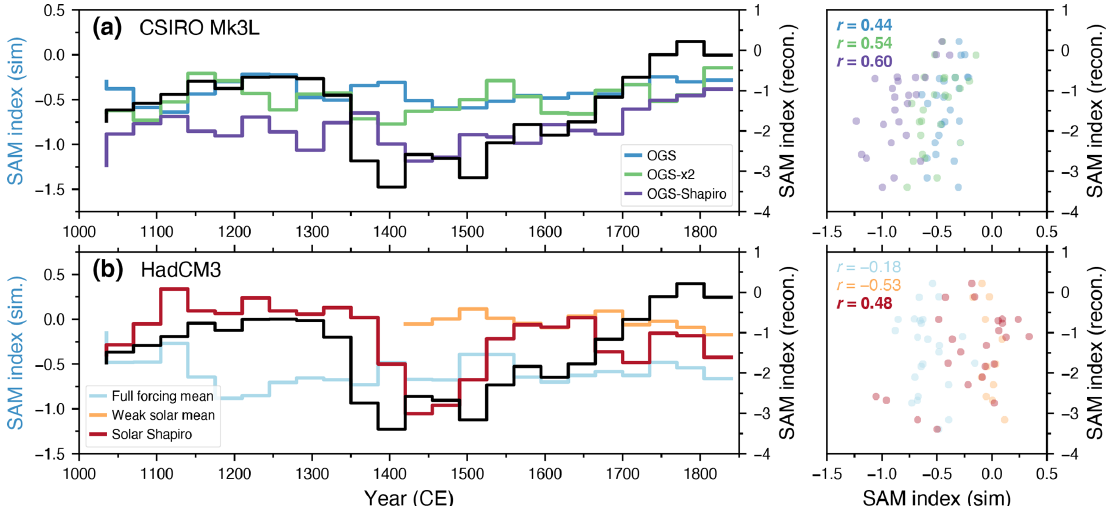
Figure 12. Comparison of simulated SAM index and the A14 SAM reconstruction between 1000 and 1900CE. Time series (left column) of the SAM index (70-year moving averages stepped by 35 years, calculated relative to 1900–1999CE historical mean) from ensemble means of transient simulations and SAM reconstructions (black line; A14) (a) for transient experiments from CSIRO Mk3L using low- (blue, OGS), intermediate- (green, OGSx2), and high-amplitude (purple, OGS-Shapiro) solar forcing (b) for simulations from HadCM3 (Schurer et al., 2014), including the full-forcing (blue), weak-solar (orange), and strong-solar (“solar Shapiro” runs using Shapiro et al., 2011; red) simulations. Note that there is only a single member for the strong-solar scenario and that the solar-forcing simulations from HadCM3 do not include greenhouse gases (whereas the full forcing simulation does). This results in the last millennium SAM index from the full-forcing simulation having a lower mean than the solar-forcing-only experiments when calculated relative to the 1900–1999CE historical mean. Scatter plots (right column) show the correlation between the simulated ensemble mean and reconstructed SAM indices, as 70-year moving averages stepped by 35 years, and r values between the simulated and reconstructed SAM index are shown in bold text where P < 0 . 05.